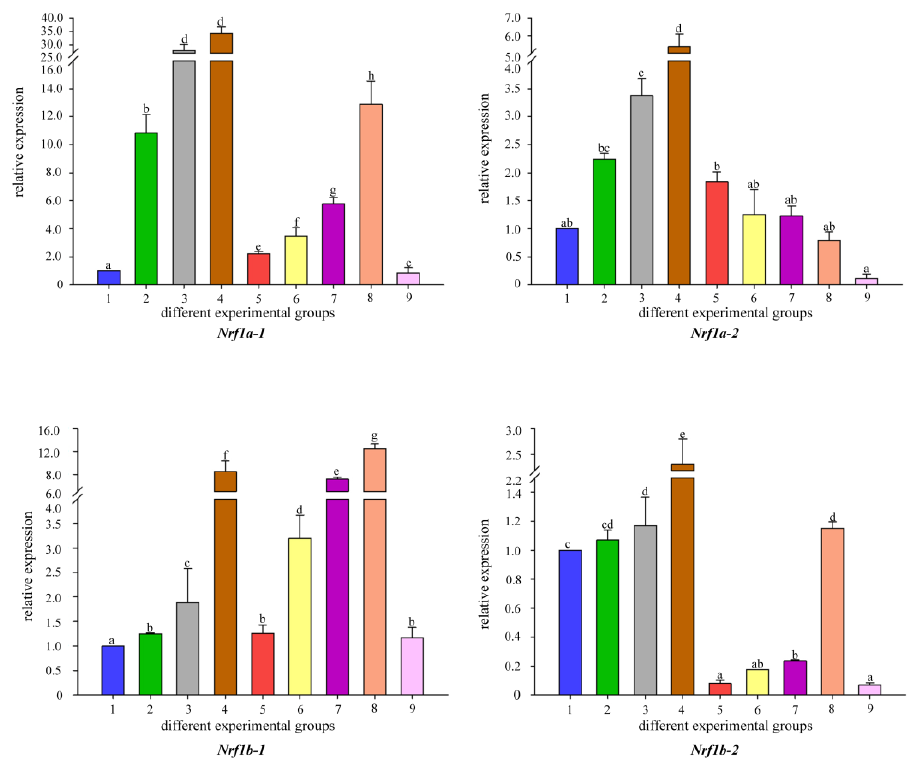
Figure 5. Temporal expression of Nrf1 mRNA relative to control and normalized by qRT-PCR for changes in β -actin in the gut of common carp, challenged for 30 and 60 days. Significant differences between the challenge, infection, and control groups are indicated by letters, p < 0.05: 1 is the blank control group; 2 is the heavy metal Cd 2+ -stress group at 30 days; 35 is the B. coagulans group with L1, L2, and L3 concentrations in the feed at 30 days; 6 is the heavy metal Cd 2+ -stress group at 60 days; 79 is the B. coagulans group with L1, L2, and L3 concentrations in the feed at 60 days group.